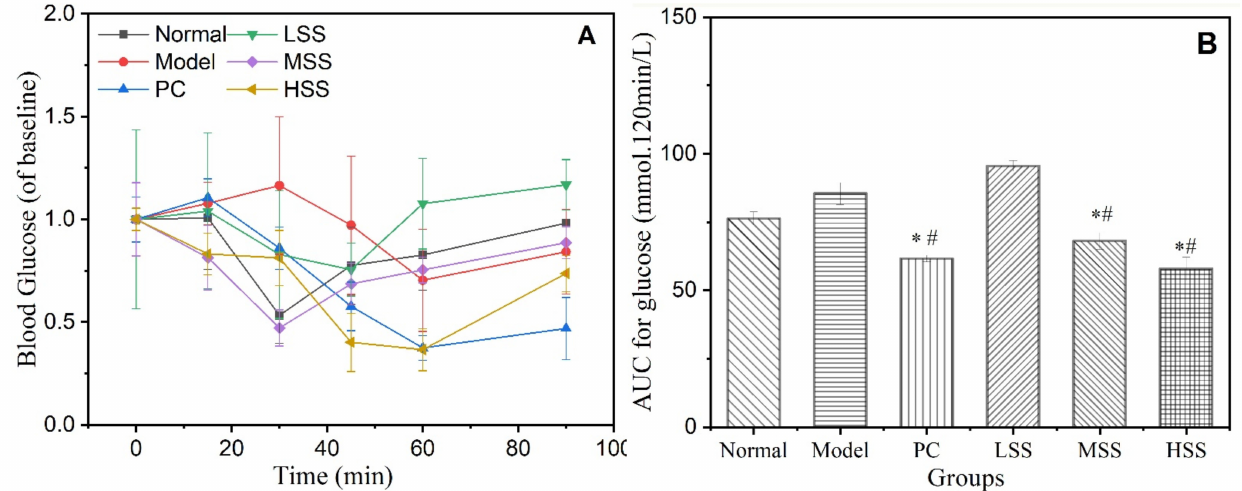
Figure 3. Effect of oral SS administration on the ITT results of T2D rats. ( A ) ITT results, with baseline blood glucose levels set to 100%; ( B ) AUC of ITT. Normal: normal group; Model: diabetic model group; PC: 0.5% metformin administration; LSS, MSS, and HSS: 1, 2.5, and 5% SS administration. n = 3, * p < 0.05, vs. normal group; # p < 0.05, vs. model group.